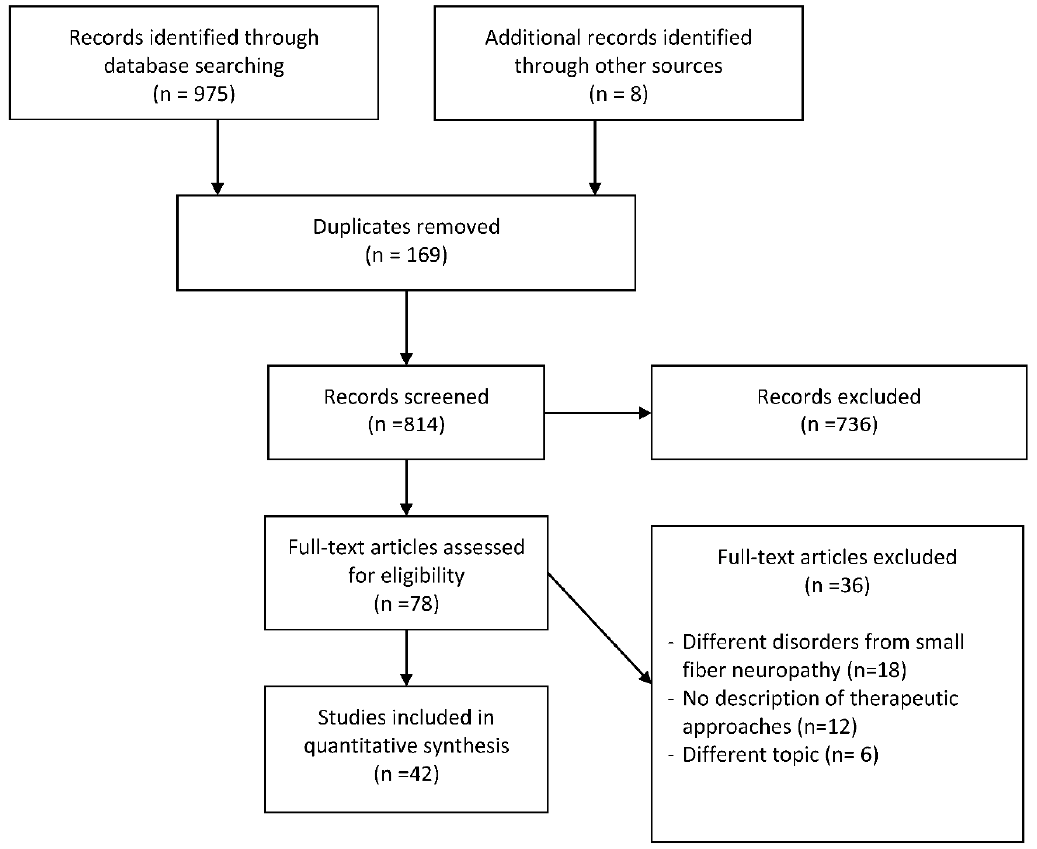
Figure 1. Flowchart of the process of literature search and extraction of studies meeting the inclusion criteria.